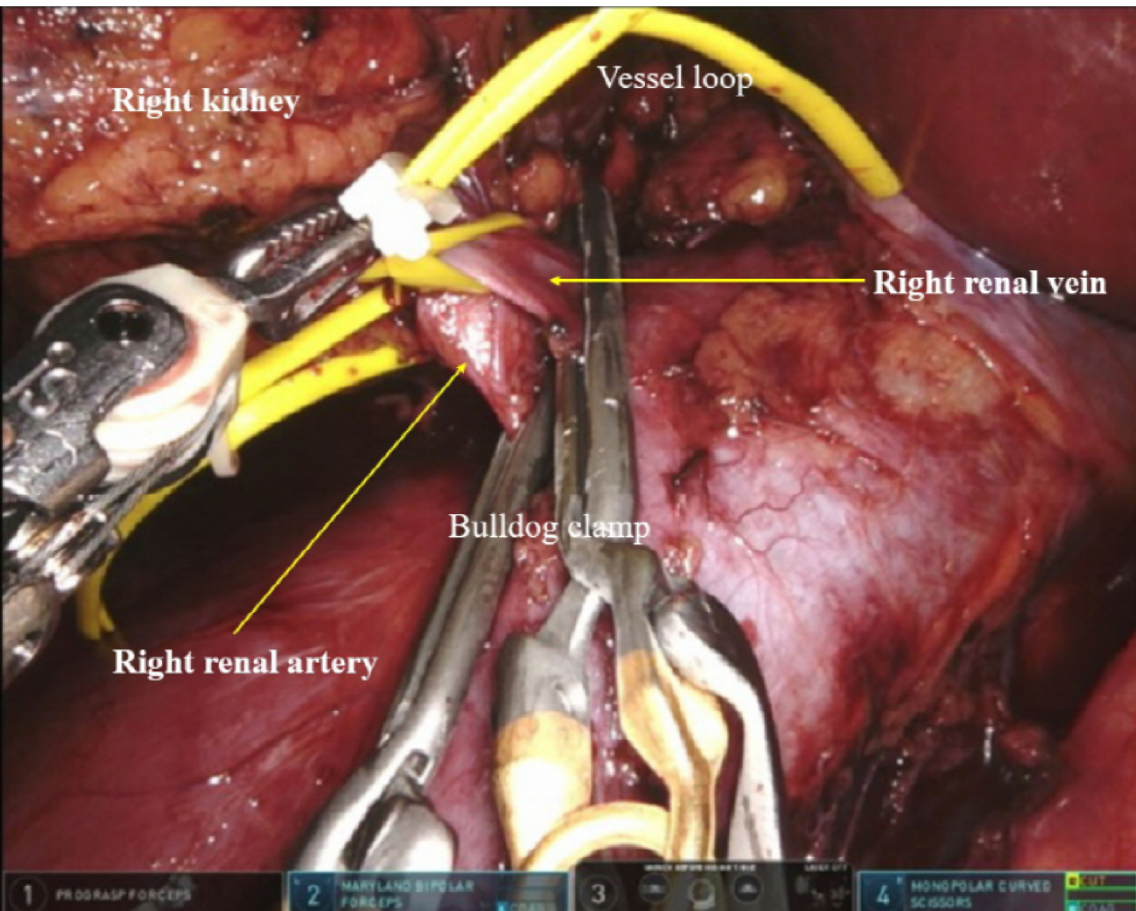
Figure 2. Renal vascular